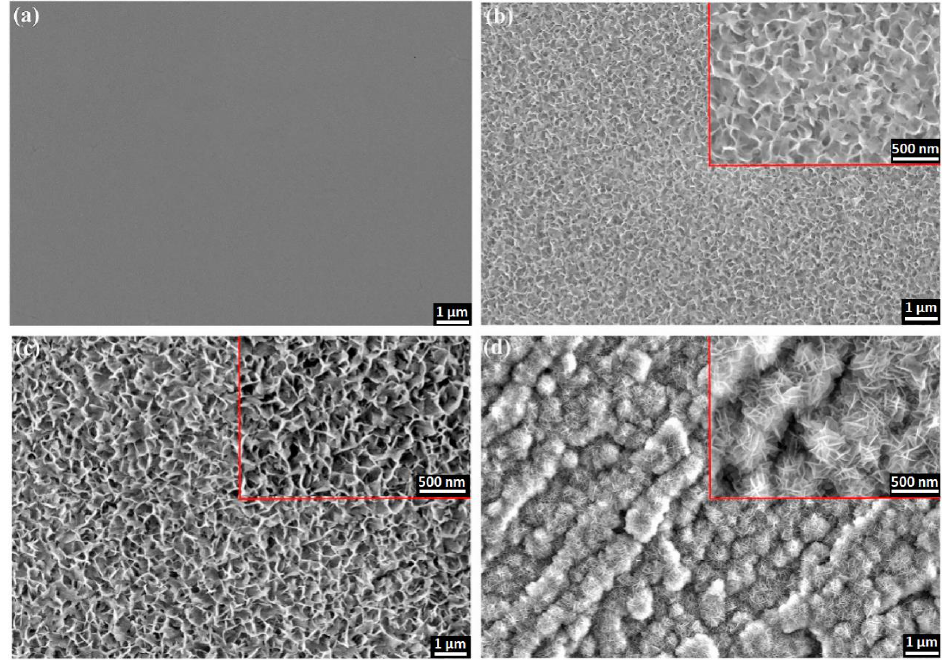
Figure 8. SEM images of hydrous oxide layer formed hydrothermal treatment of aluminum foils at 97 ± 2 ◦ C for ( a ) 0 s, ( b ) 30 s, ( c ) 10 min, and ( d ) 60 min. Reprinted with permission from